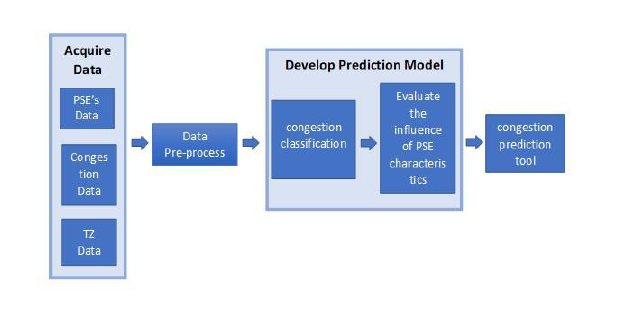
Figure 3. Proposed